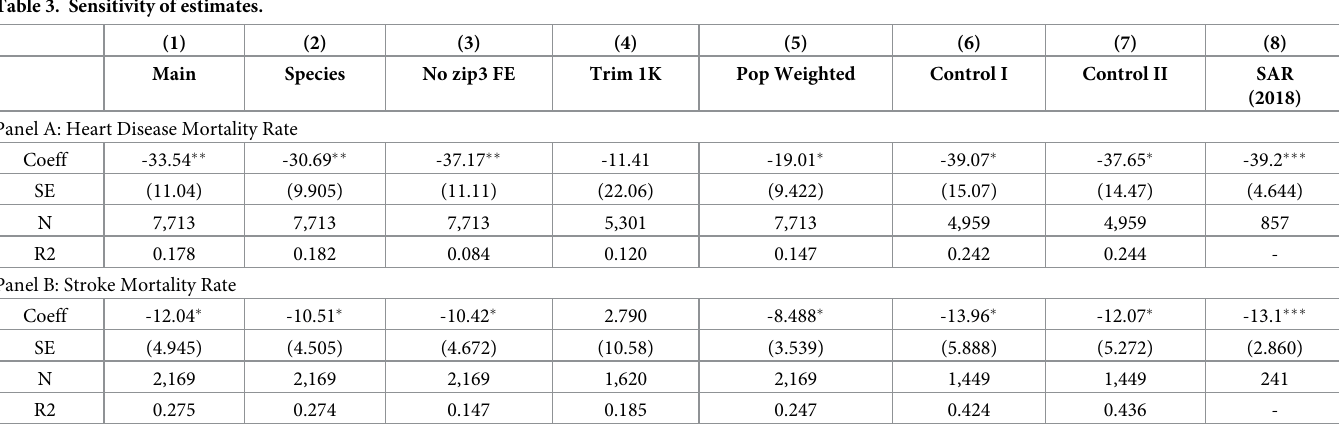
Table 3. Sensitivity of